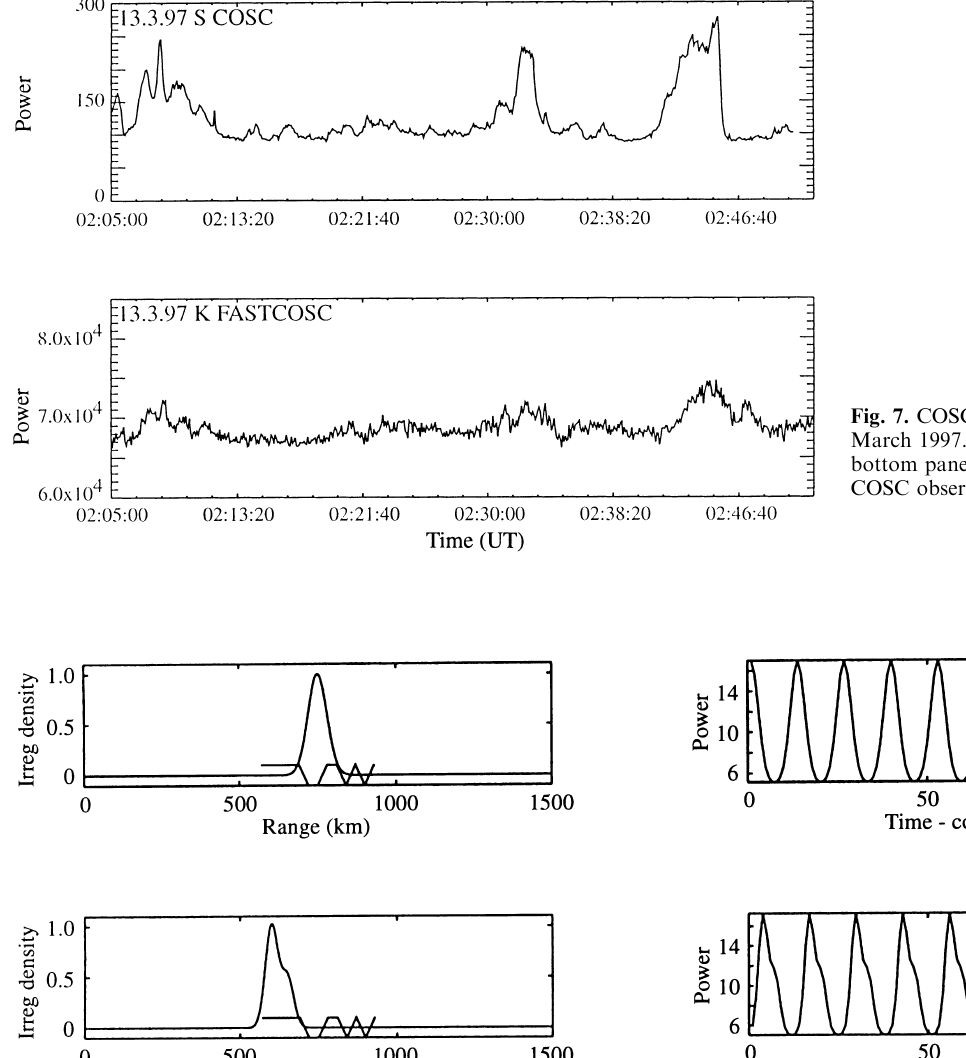
Fig. 7. COSC and FAST-COSC data from 13 March 1997. Top panel : COSC power; bottom panel : 5-s post integrated FAST- COSC observations